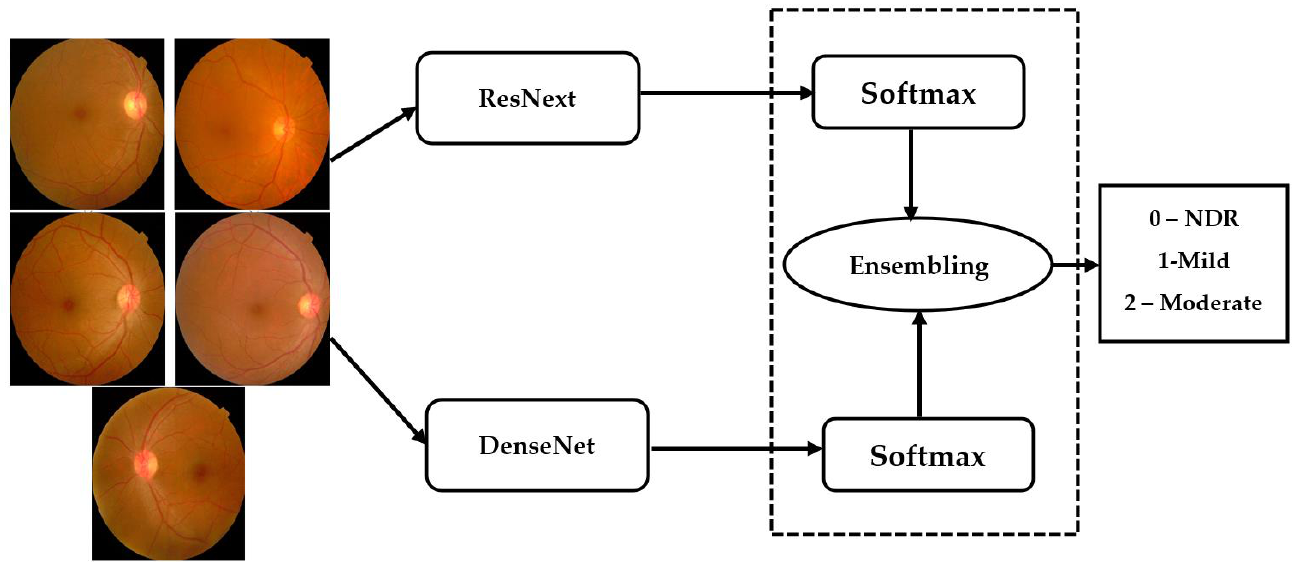
Figure 7. Ensembling